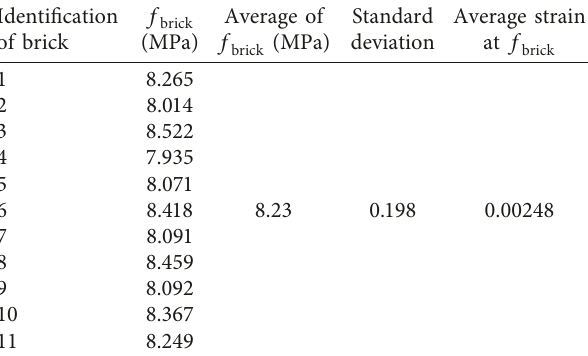
Figure 1: Masonry element for shear friction test (unit: mm). Table 1: Compressive strength of bricks